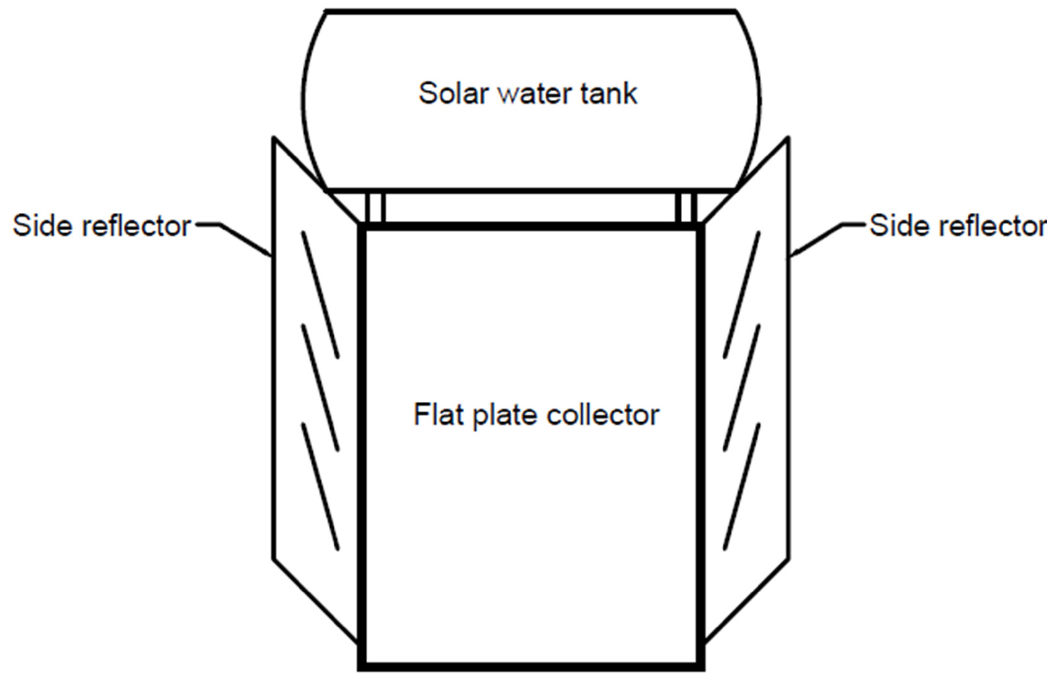
Figure 20. The illustration of a flat-plate solar collector with side reflectors [157].